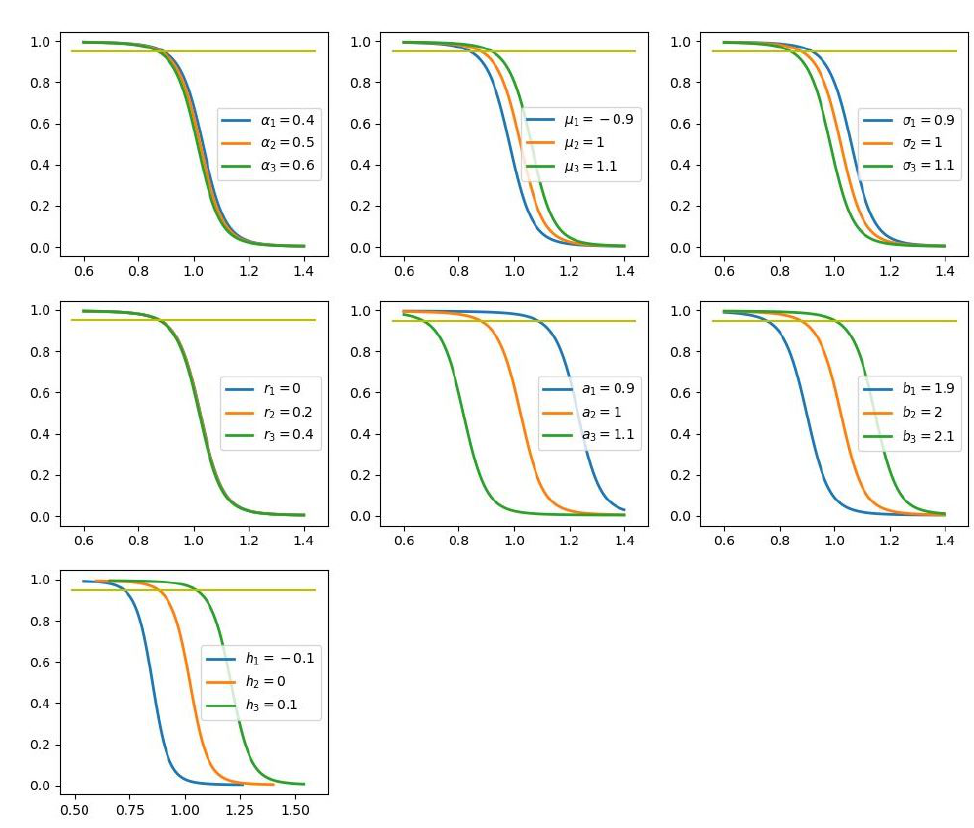
Figure 5. The figures show the graph of u 1 ( x ) for three different values of each parameter indicated in the figures for the exponential OU model. The horizontal line cuts the probability of stop at a confidence level of